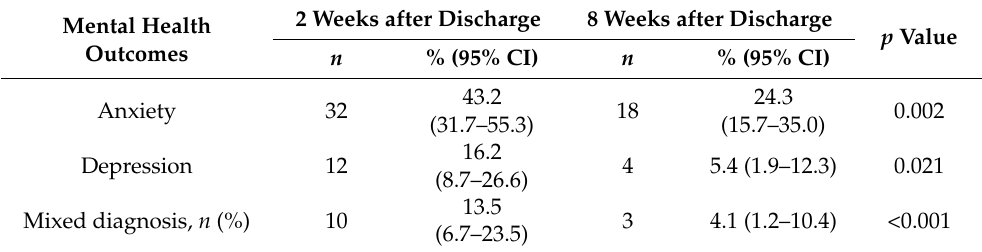
Table 2. The proportion of family members with symptoms of anxiety and depression at 2 and 8 weeks after discharge of their relatives with COVID-19 from the study sites ( n = 74).